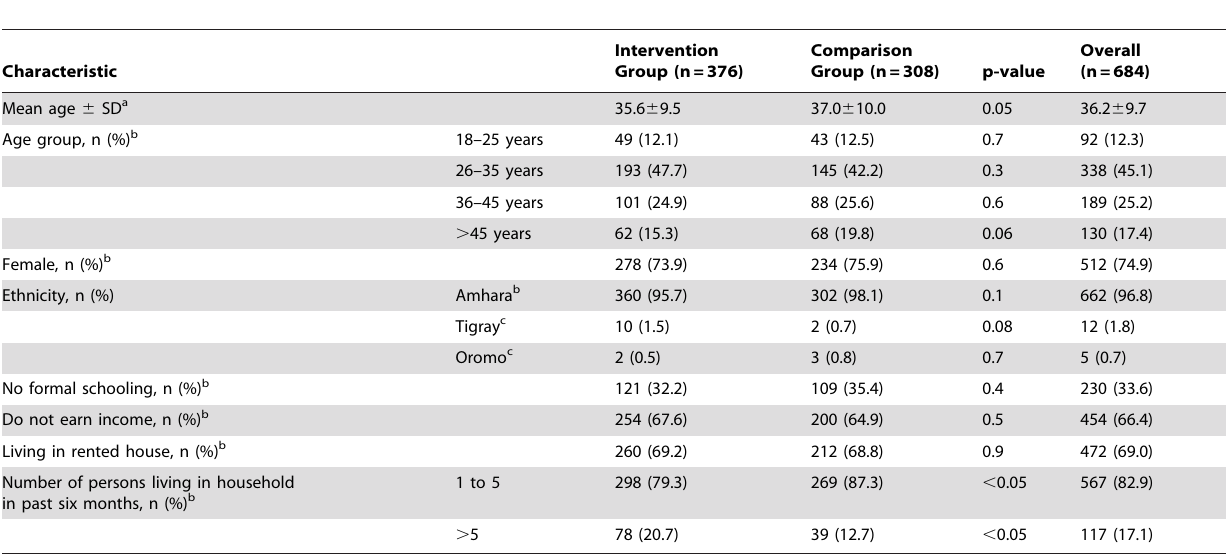
Table 1. Baseline demographic characteristics of study participants in intervention and comparison groups, basic care package evaluation, Gonder and Debre Markos, Ethiopia, October 2009.